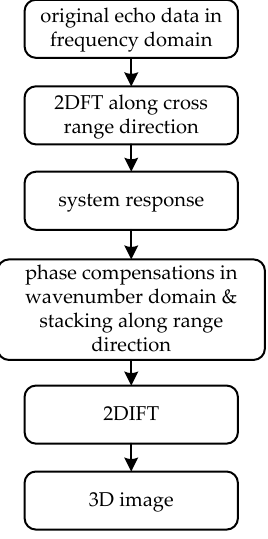
Figure 2. Block diagram of PMA for monostatic case.